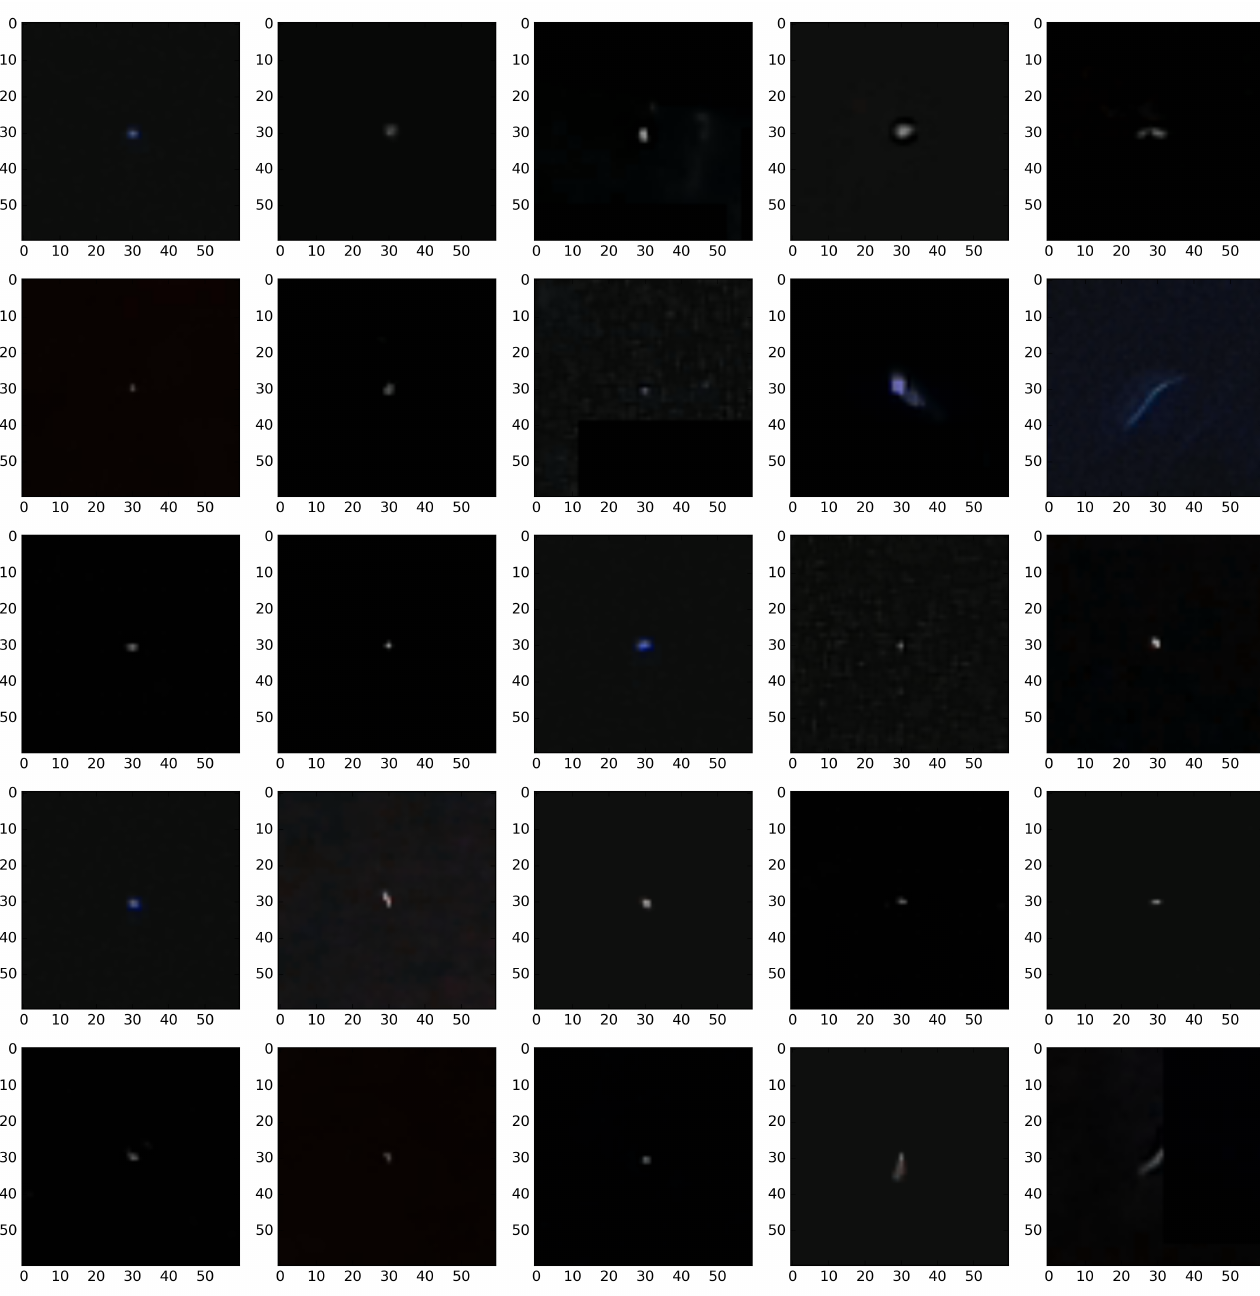
Figure 15. Classification on the selected part of the original CREDO set demonstrating signal class. An example of the performance of a classifier based on a dimension 2 input tensor composed of the greyscale image and a D2